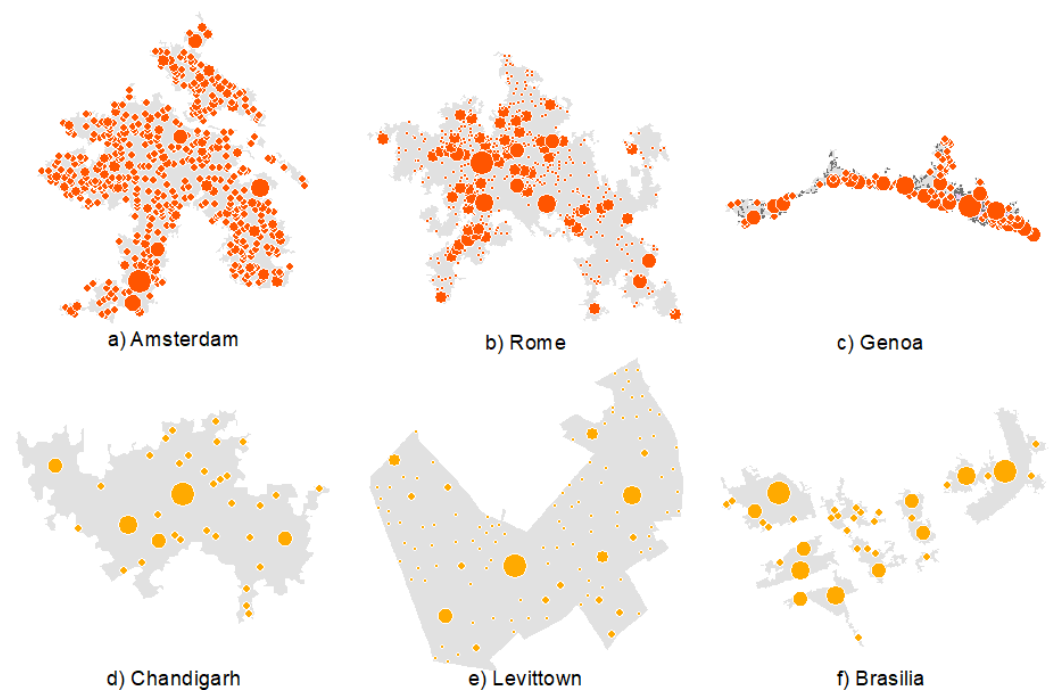
Figure 5. Hotspot comparison between artificial and historic cities. Each city shows its hotspots within its borders. Hotspots are classified according to head/tail breaks. In red, the historical cities are shown ( a – c ), and the artificial cities are shown in orange ( d – f ). For visualization, the lowest classes within the head/tail breaks 2.0 are not shown except for Levittown, which shows all classes. Larger hotspots are shown by the larger circles, and the smaller hotspots are shown in smaller circles, classified according to head/tail breaks.